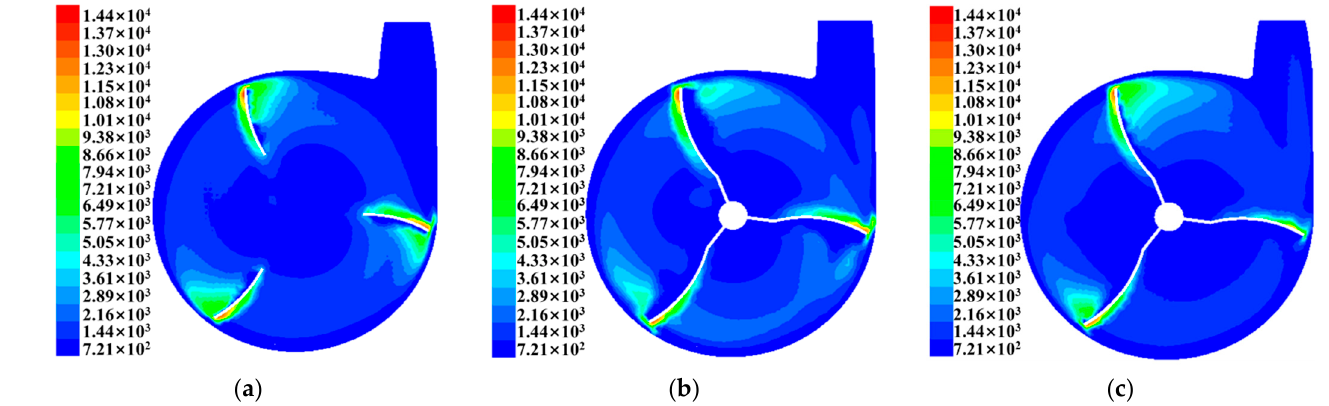
Figure 11. The dynamic pressure cloud diagram of crushed straw material phase with different cross-sections along the Y-axis in the impeller volute area. ( a ) Y = − 46 mm. ( b ) Y = 0 mm. ( c ) Y = 46 mm.